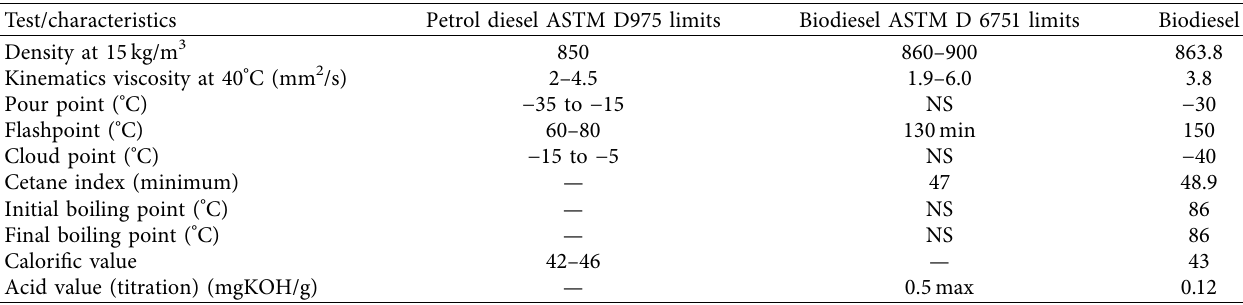
Table 4: Physicochemical properties of neem biodiesel.